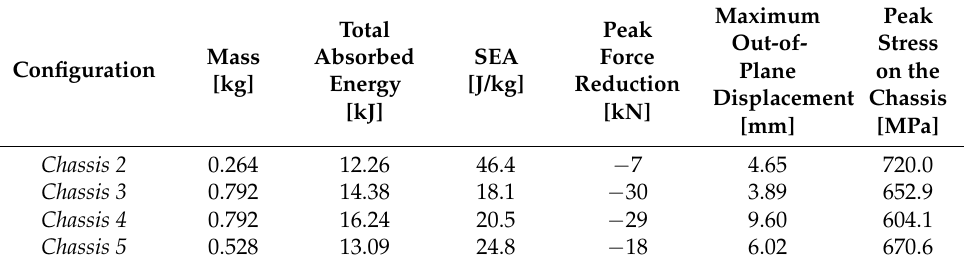
Table 4. Results